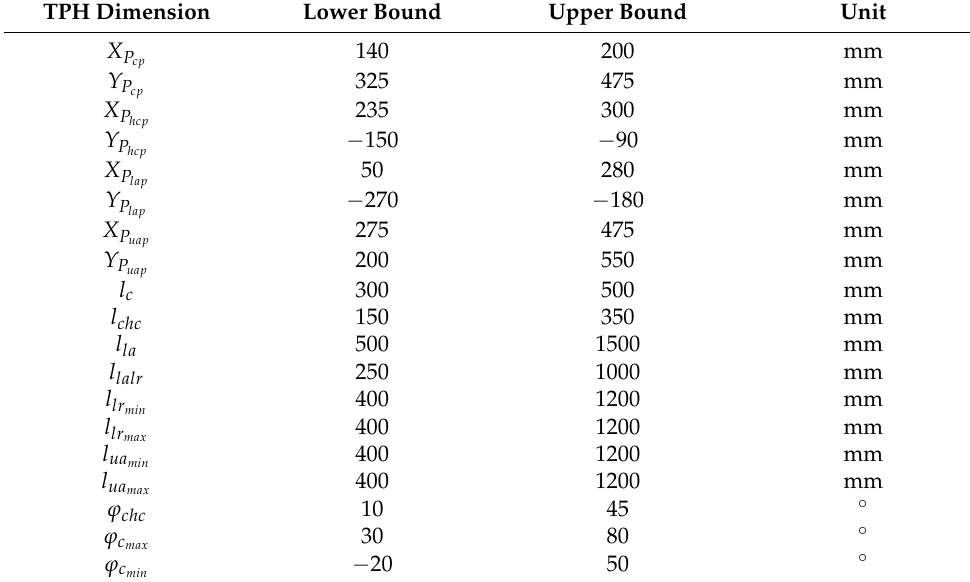
Table 5. Lower and upper bounds on the TPH dimensions subject to optimisation.